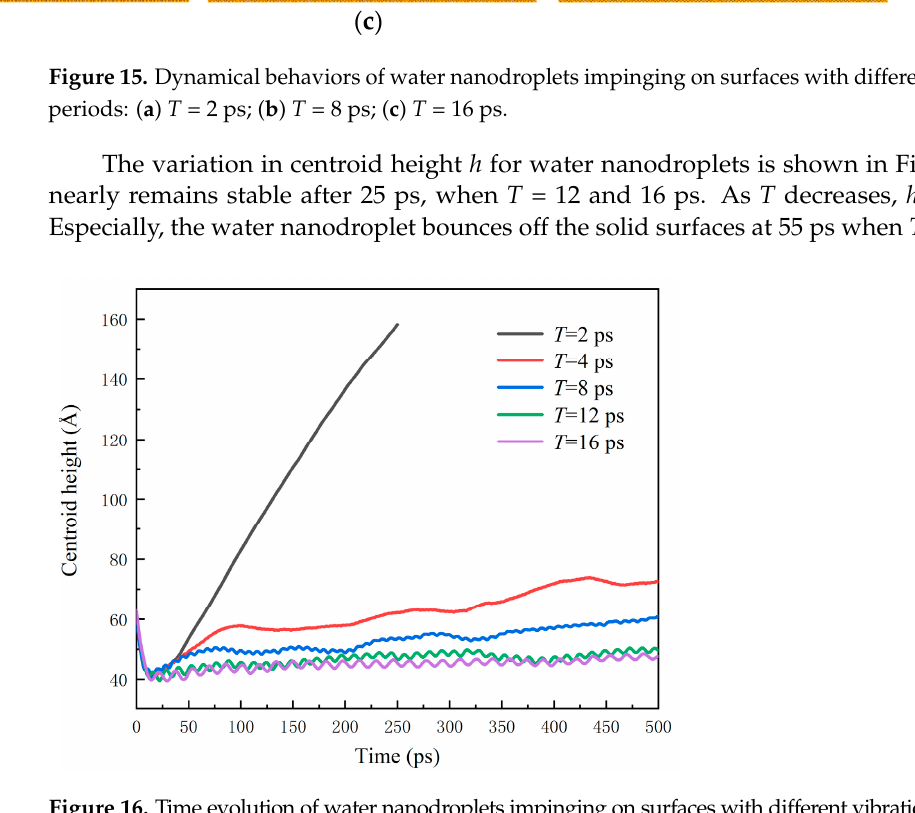
Figure 15. Dynamical behaviors of water nanodroplets impinging on surfaces with different vibra- tion periods: ( a ) T = 2 ps; ( b ) T = 8 ps; ( c ) T = 16 ps.